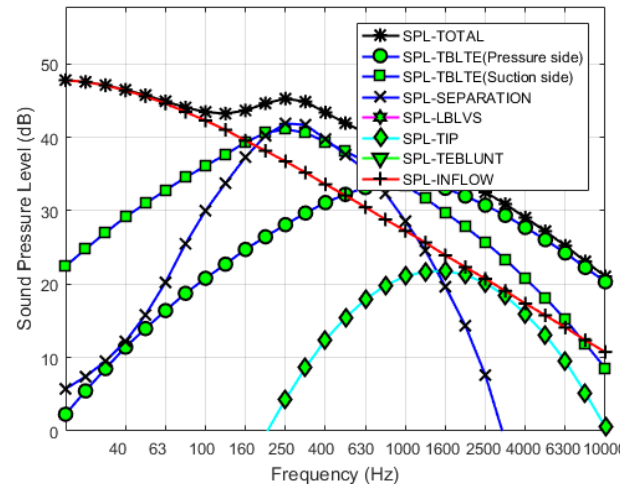
Figure 11. Aerodynamic noise source spectra of a single wind turbine.